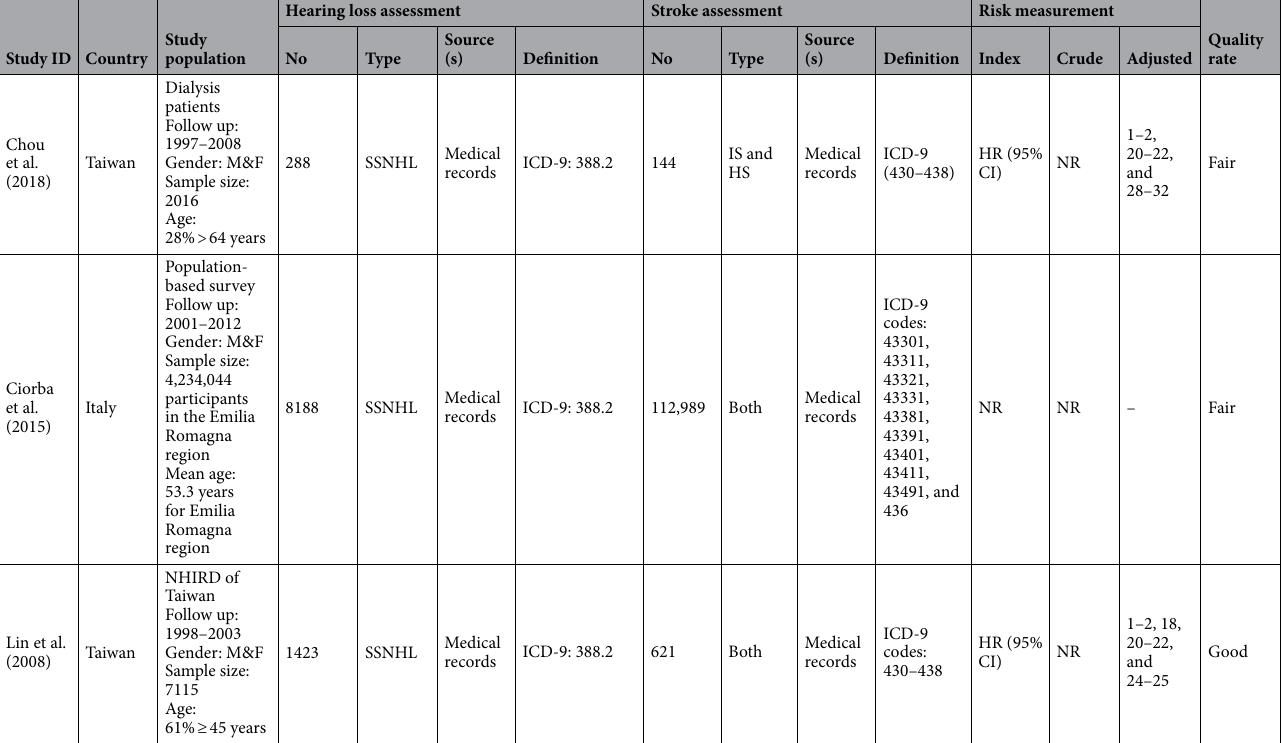
Table 1. Description of the studies included in the meta-analysis. M male, F female, SSNHL sudden sensorineural hearing loss, ARHL age-related hearing loss, IS ischemic stroke, HS hemorrhagic stroke, ICD